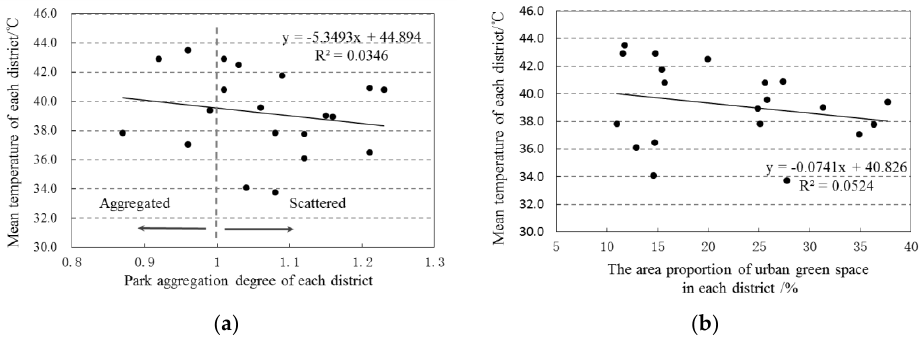
Figure 6. Cooling effect diagram of urban green space distribution. ( a ) Represents the relationship between aggregation of urban green space of each district and mean temperature of each district in five time periods of remote sensing imagery data. When the value is 1, the urban green space distribution is random, when the value is less than 1, the distribution is aggregated, and when the value is more than 1 the distribution is scattered; and ( b ) represents the relationship between the proportion of area of urban green space in each district and mean temperature of each district in the same images.